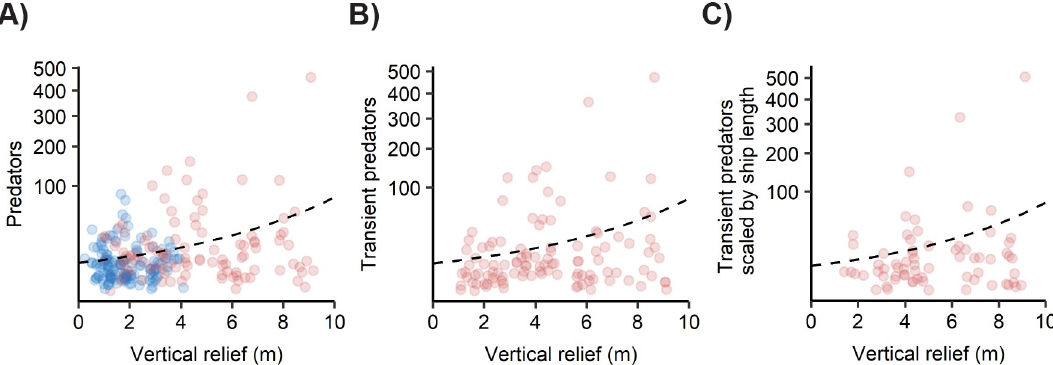
Fig 4. Association between vertical relief of reefs and predator density. A) Density of all predators (transient and resident) on artificial reefs (red) and natural reefs (blue). N = 109 artificial reef transects and 127 natural reef transects. B) Density of transient predators on artificial reefs. N = 109 artificial reef transects. C) Density of transient predators scaled by reef length for ship-type artificial reefs. N = 69 artificial reef transects on ships of known lengths. Black dashed lines are predicted fit of the GLMs.